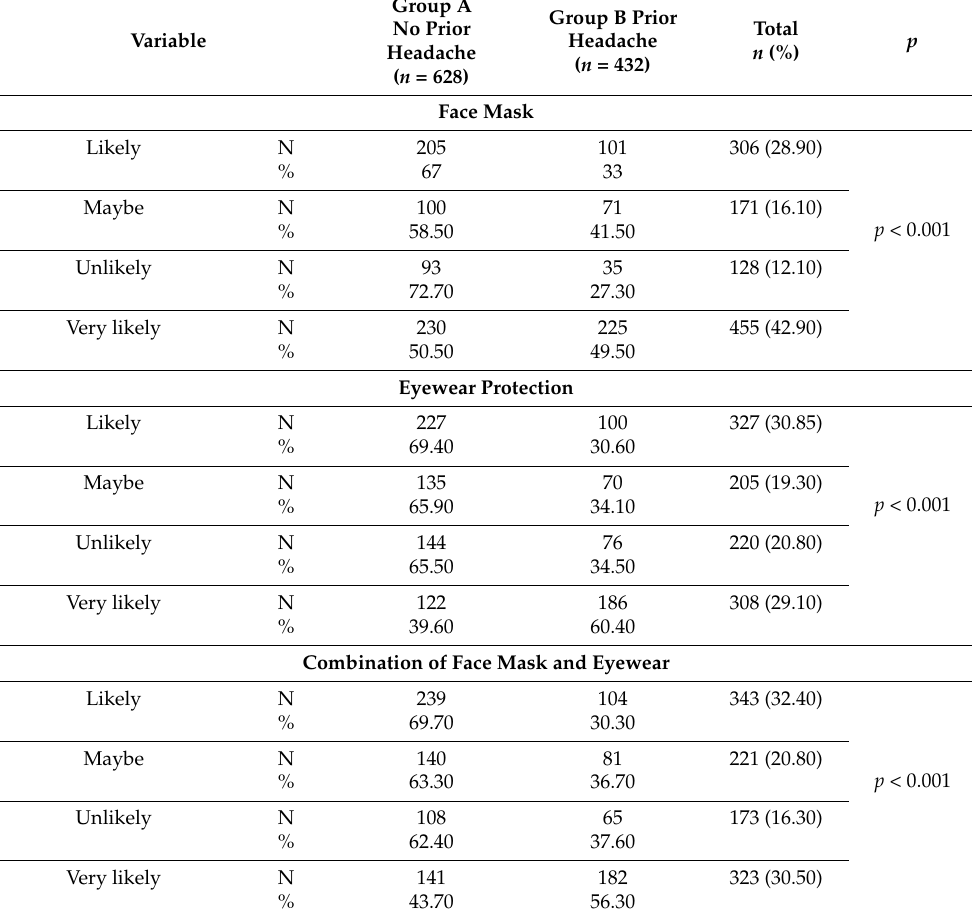
Table 4. Comparison of Participants’ Personal Protective Equipment Usage using the Chi Square